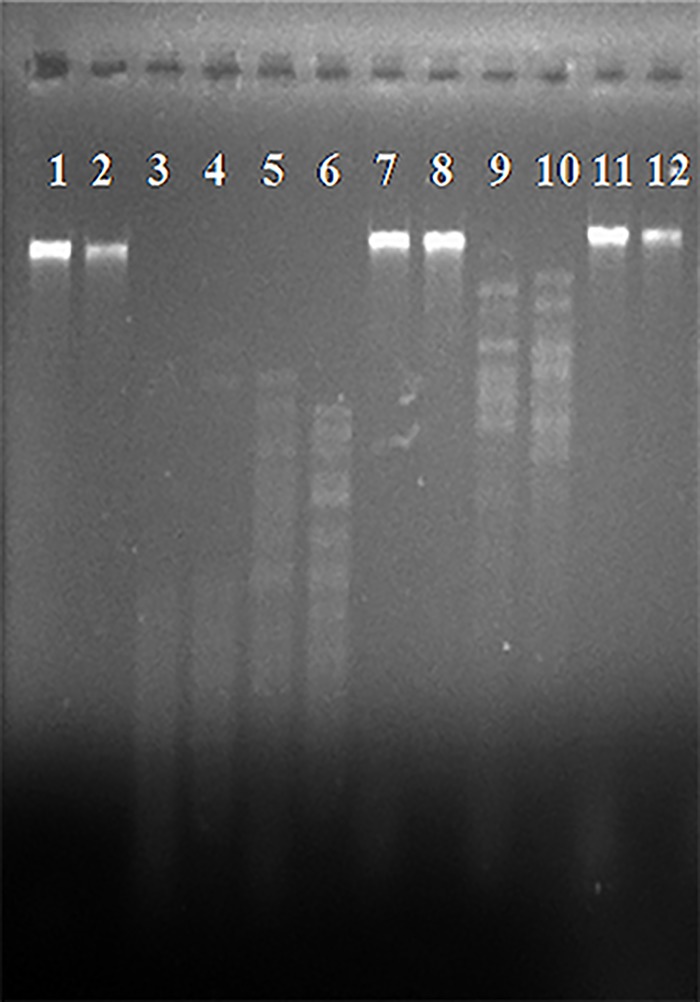
Restriction endonuclease digestion profile of φSt2 and φGrn1 DNAs.1: φSt2—HpaII, 2: φGrn1—HpaII, 3: φSt2—Sau3AI, 4: φGrn1—Sau3AI, 5: φSt2—HincII, 6: φGrn1—HincII, 7: φSt2—HaeIII, 8: φGrn1—HaeIII, 9: φSt2—BgIII, 10: φGrn1—BgIII, 11: φSt2—BamHI, 12: φGrn1—BamHI.